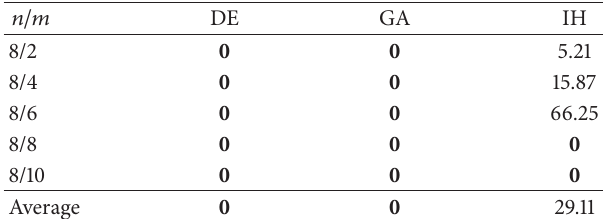
Table 3: Mean percent deviation for small size